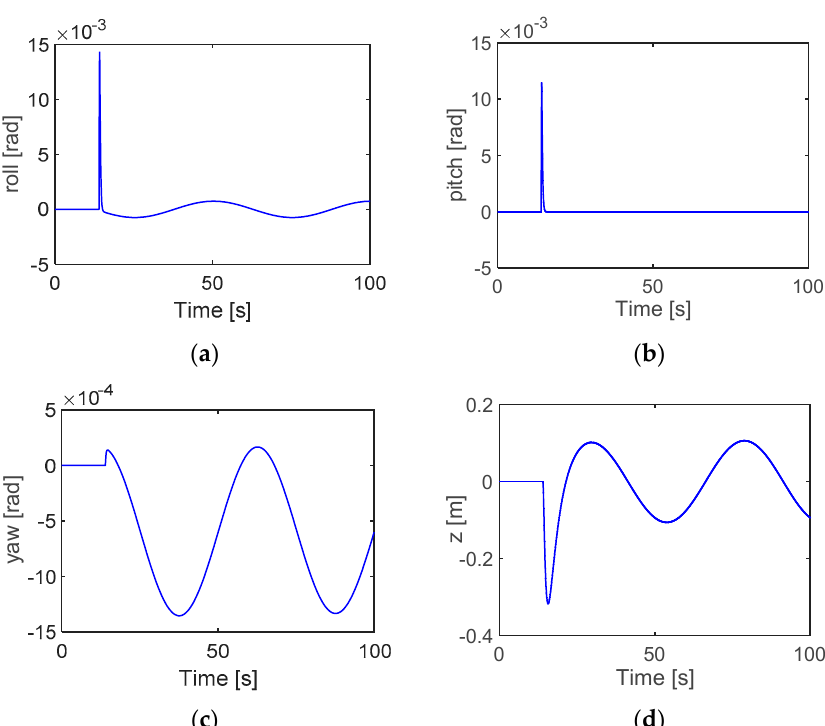
F fault offset and ( b ) 1